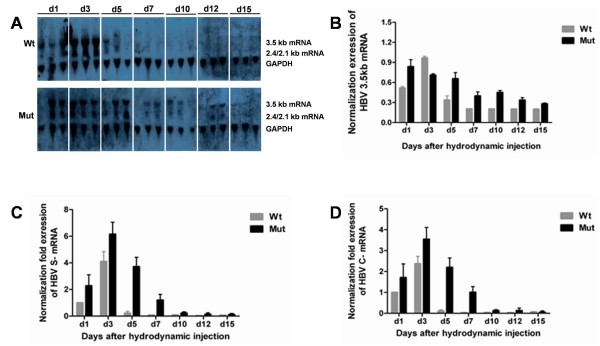
Time-dependent viral transcription after hydrodynamic transfection in vivo.A: HBV RNA of mice liver were detected by Northern blotting, and GAPDH transcript was used as an internal control for RNA loading per lane; B: The 3.5-kb HBV mRNA was quantitatively calculated automatically by the Quantity-One software (Bio-Rad); C or D: The total levels of HBV S-mRNA or C-mRNA in mouse liver were detected by qPCR, and the mean value of Wt of day 1 was defined as 1.